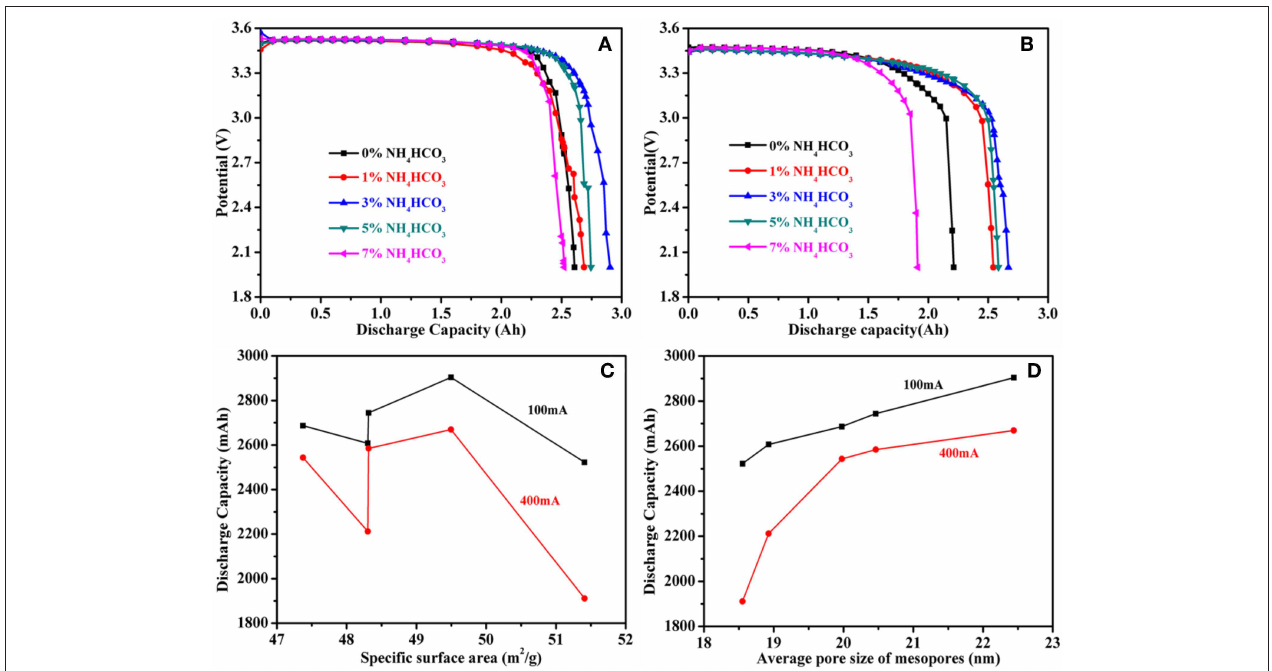
FIGURE 5 | (A) The discharge capacity of the ER18505M cell at 100mA, (B) the discharge capacity of the ER18505M cell at 400mA, (C) the discharge capacity and specific surface area curve, (D) the discharge capacity vs. the average pore size of